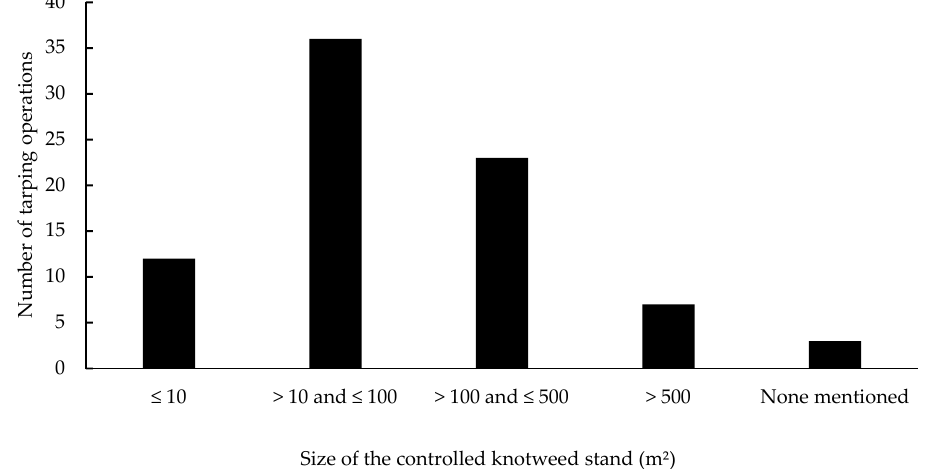
Figure 4. Size of the tarped knotweed stands based on respondents’ answers, for a total of 81 tarping operations.